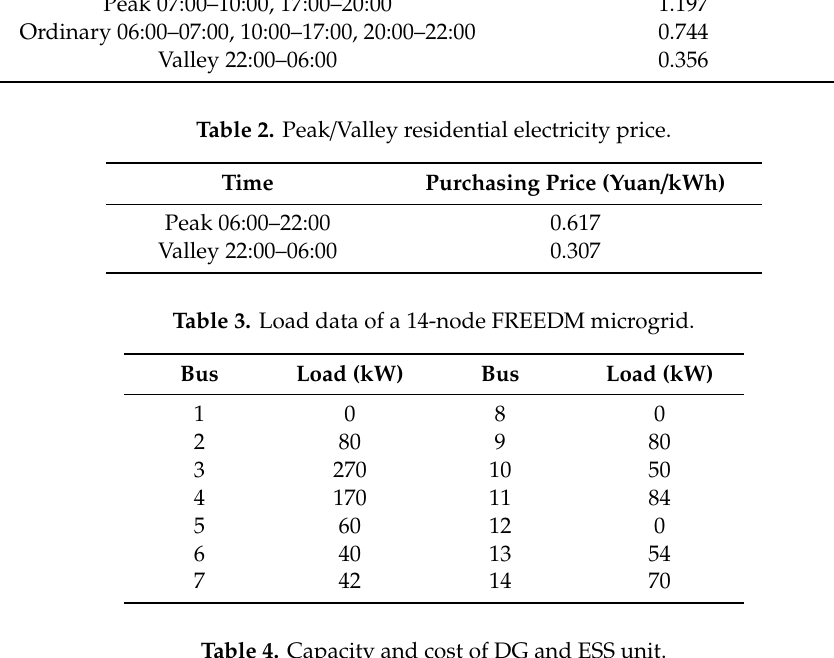
Table 4. Capacity and cost of DG and ESS